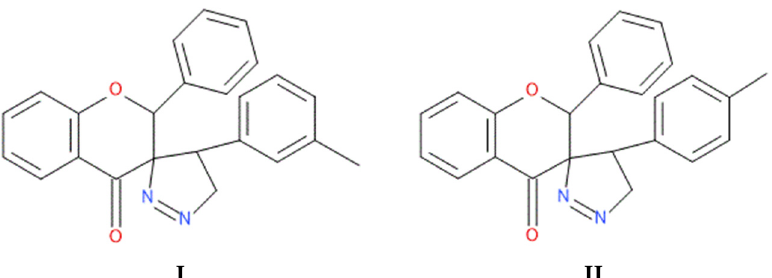
Figure 1. The chemical structure of compound I and II